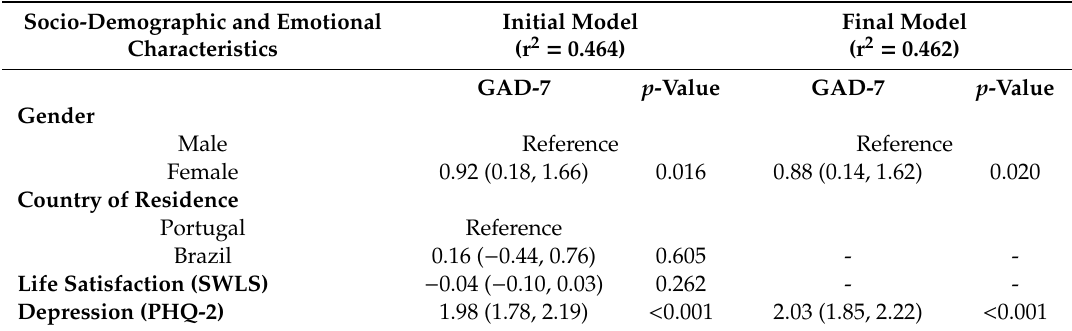
Table 4. Regression coe ffi cients for Generalized Anxiety Disorder-7 (GAD-7) as an outcome with socio-demographic and emotional variables as predictors, from univariate multiple linear